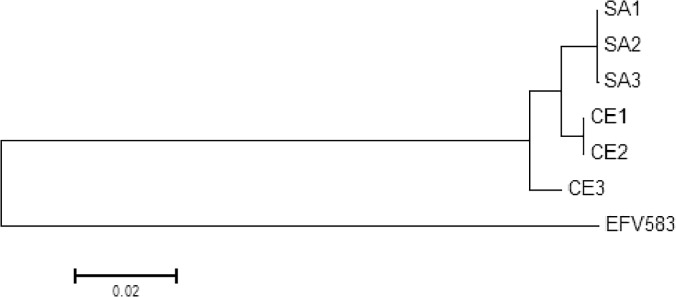
Molecular Phylogenetic Analysis of EC Genomes.The evolutionary history was inferred by using the Maximum Likelihood method based on the Tamura-Nei model. The tree with the highest log likelihood (-12083.9639) is shown. Initial tree for the heuristic search was obtained automatically by applying Neighbor-Join and BioNJ algorithms to a matrix of pairwise distances estimated using the Maximum Composite Likelihood (MCL) approach, and then selecting the topology with superior log likelihood value. The tree is drawn to scale, with branch lengths measured in the number of substitutions per site. The analysis involved 5 concatenated nucleotide sequences and used E. faecalis V583 as an outgroup. Evolutionary analyses were conducted in MEGA6.